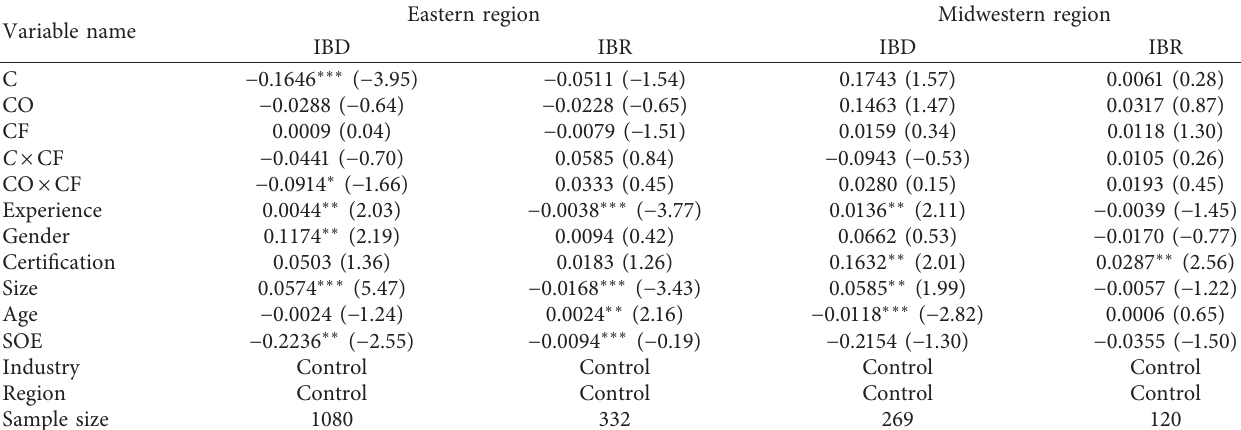
Table 5: Regression results of enterprises in different